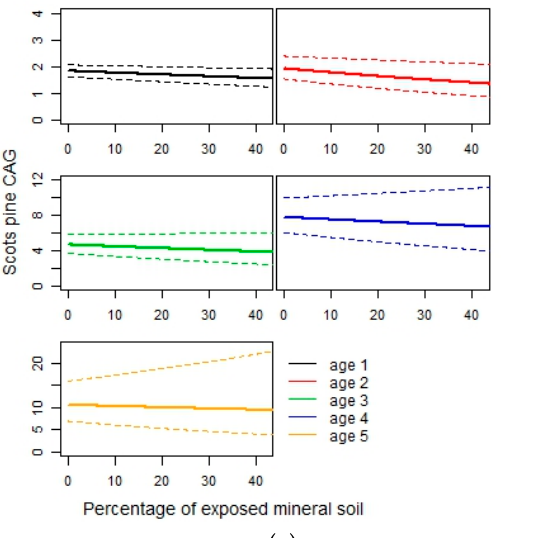
for ( a ) is based on an average contribution of the effect of proportion of exposed humus at the mean